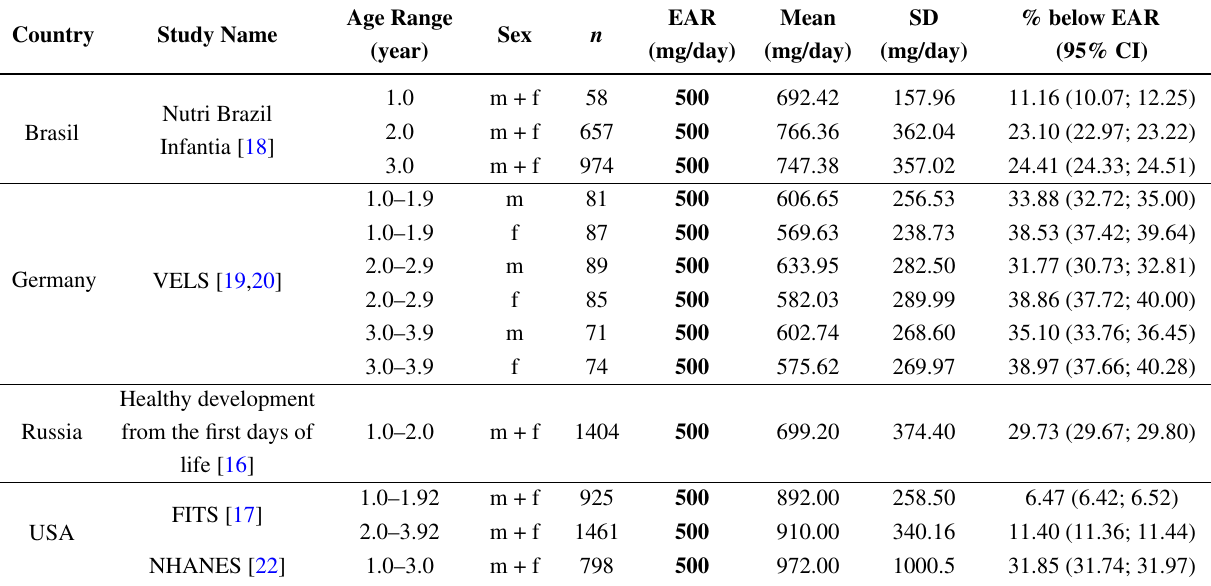
Table 7. Mean calcium intake (mg/day) and prevalence of inadequate intake (% below EAR) in Brazil, Germany, Russia and the United